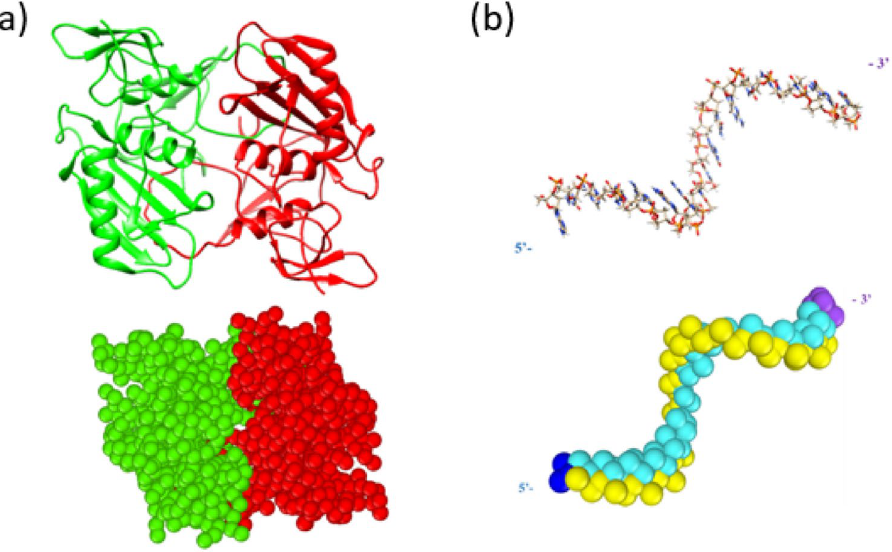
Figure 1. The upper panels show the all atom model and the lower panel show the CG model using the MARTINI force field for ( a ) the structure of epithelial cell adhesion molecule (EpCAM) dimer and ( b ) the EpA aptamer (Apt EpA ) with the sequence 5 ′ -ACA GAG GTT GCG TCT GT-3 ′ . The Apt EpA backbone and nucleobase are shown in yellow and cyan, while the 5 ′ and 3 ′ beads are colored in dark blue and